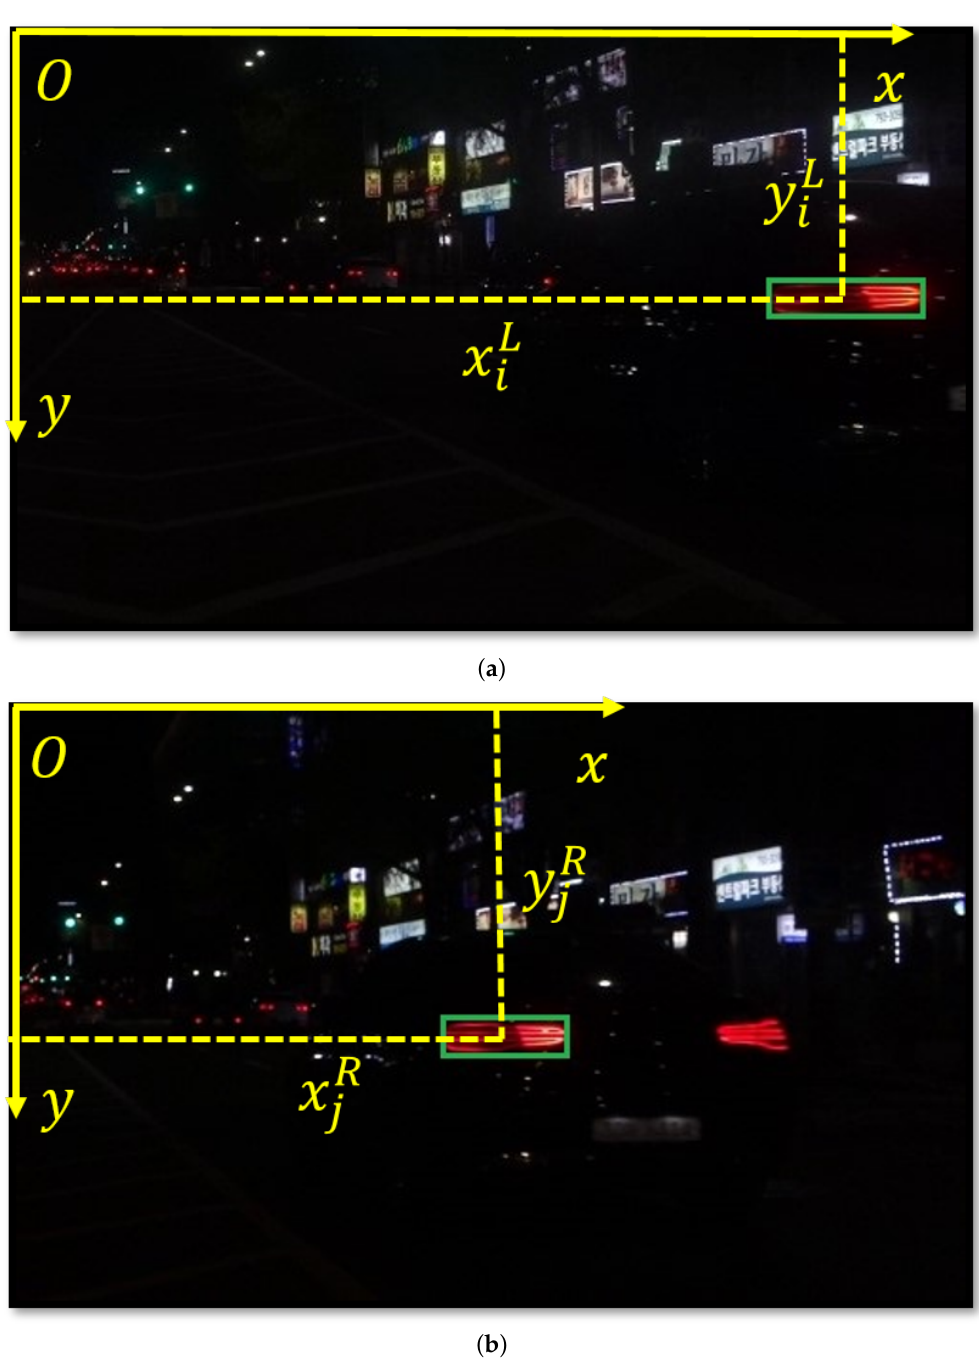
Figure 16. Pixel coordinates of the taillight in: ( a ) left image; ( b ) right